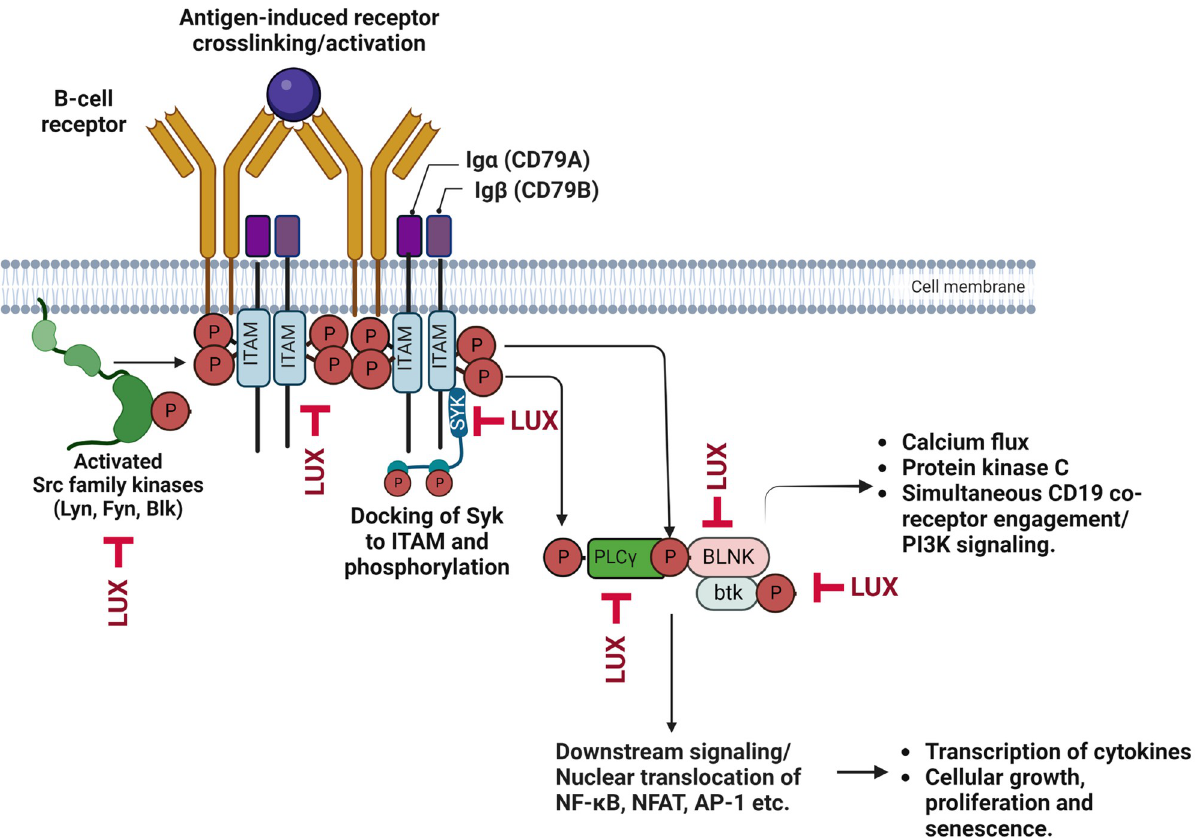
Fig 7. Summary of important kinases of the BCR signaling pathway whose phosphorylation is reduced by LUX following activation by anti-IgM in lymphoma cells. The figure was created with Biorender.com.